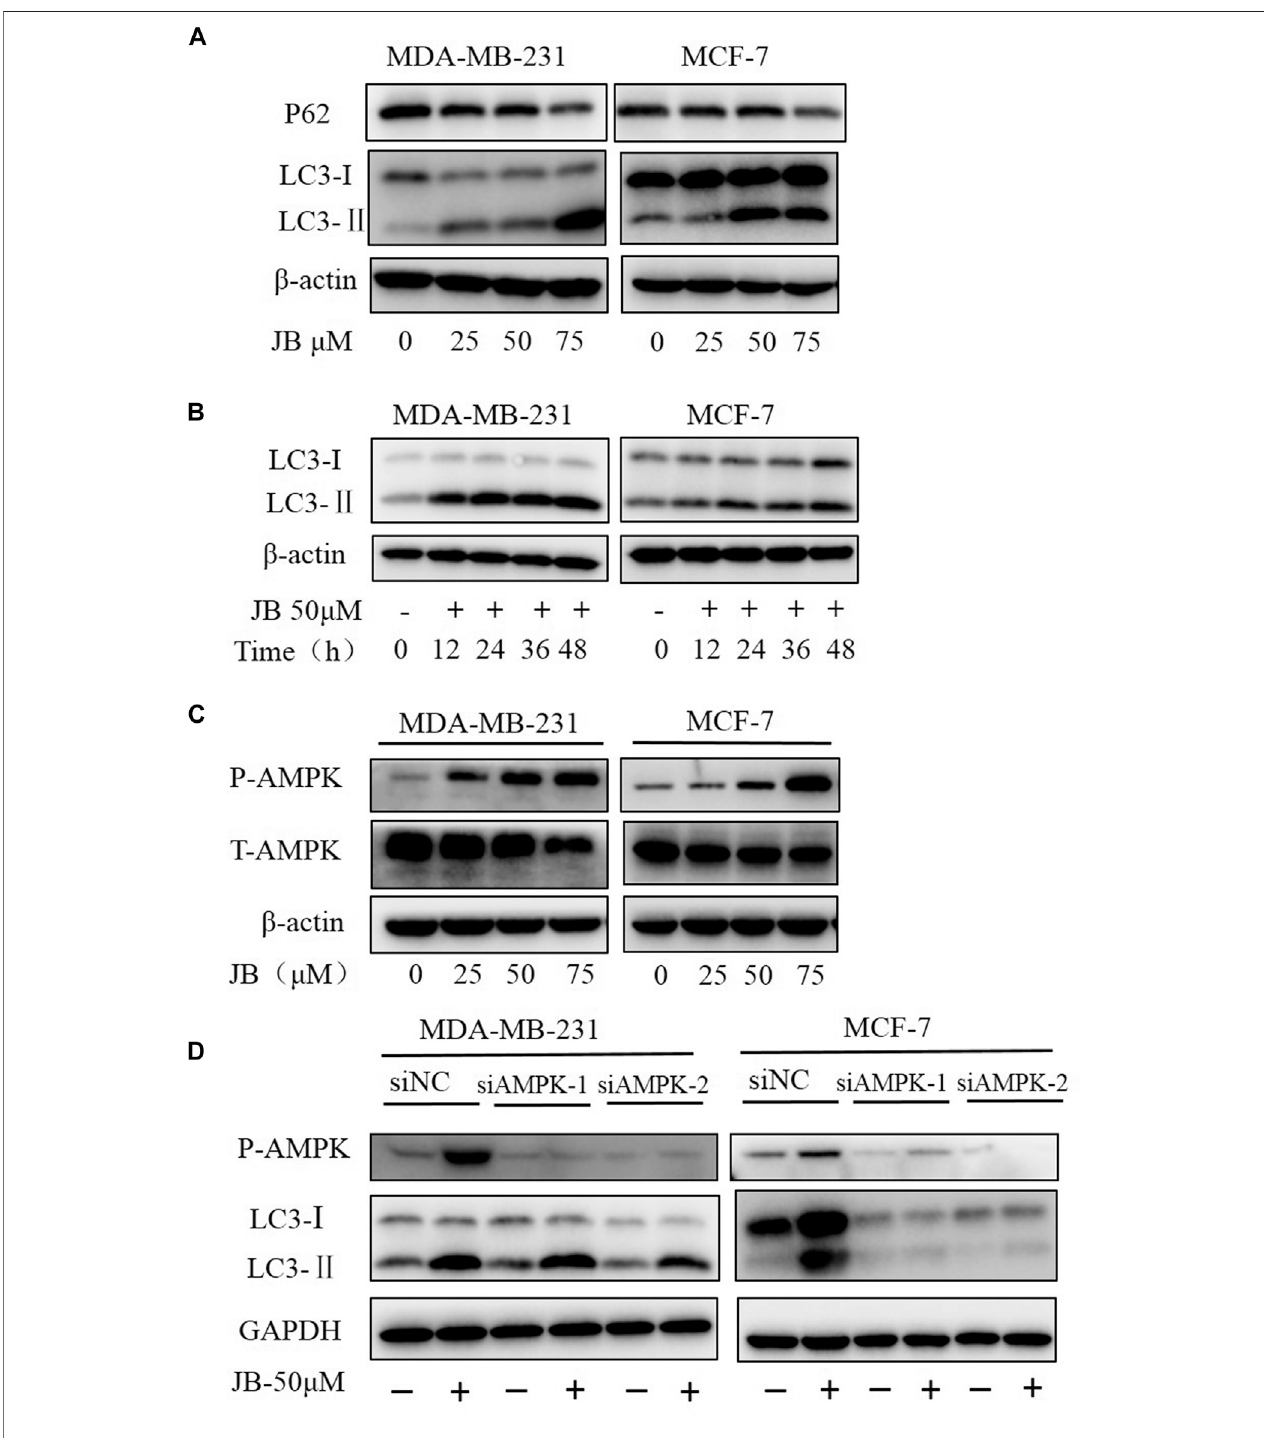
FIGURE 4 | JB induces autophagy in MDA-MB-231 and MCF-7 cell lines. Cells were treated with DMSO or indicated concentrations of JB for 48 h and harvested forcelllysispreparation.TheexpressionsofLC3-I,LC3-II,andp62weredetectedbywesternblot (A) .CellsweretreatedwithJB-50 μ Minatimecourseof0,12,24,36, and 48 h and then harvested for cell lysis preparation. The accumulation of LC3-II over time was determined by western blot (B) . The expression levels of phospho- AMPK and total AMPK were detected bywestern blot (C) . Transfection ofsiRNA wasconducted to knock down the expression ofAMPK followed by treatment of JB for 48 h. Cells were collected and prepared into lysis. The expression levels of P-AMPK, LC3-I, and LC3-II were determined by western blot (D) .